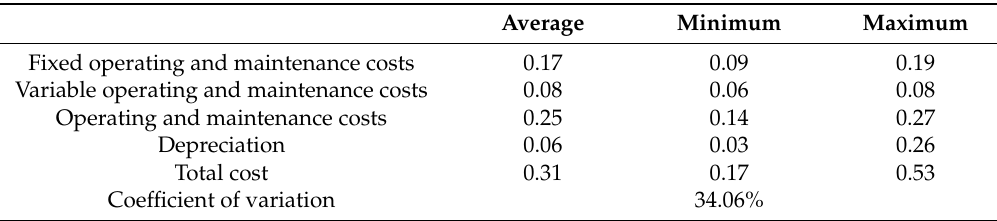
Table 5. Cost in € per m 3 of treated water in the province of Jaén in 2017.